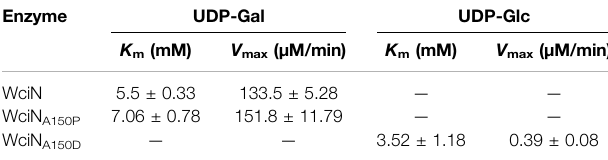
TABLE 2 | Enzyme kinetics using UDP-Gal and UDP-Glc as